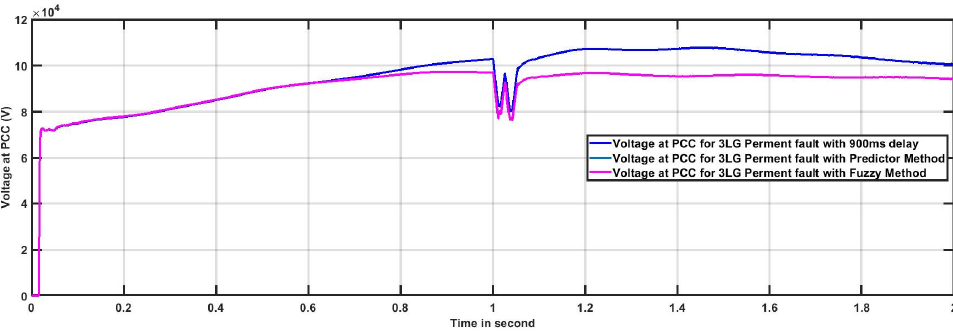
Figure 14. 3LG permanent faulty PCC voltage at location B.